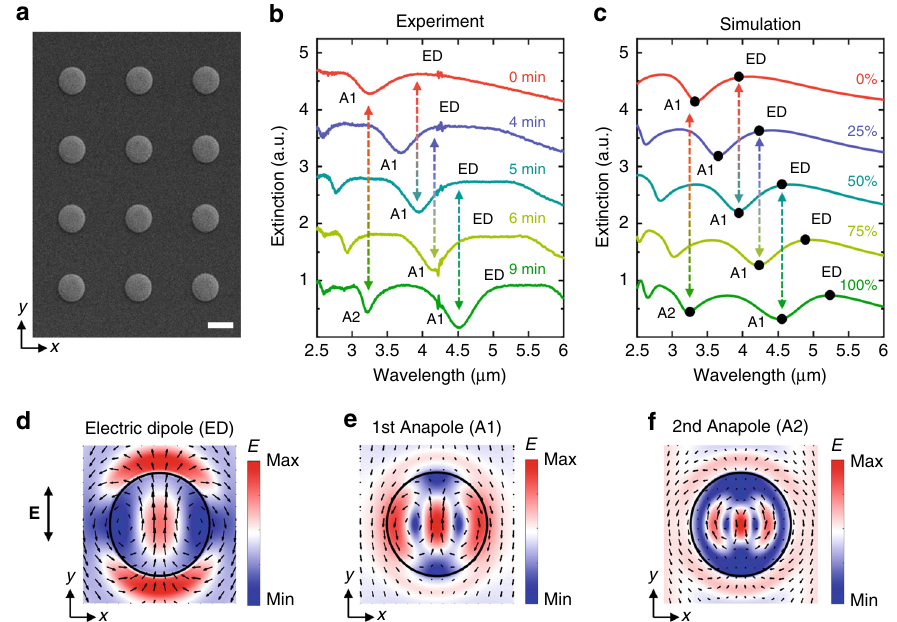
Fig. 3 Experimental realization of active tunable anapole states in structured GST nanodisks. a SEM image of the fabricated GST disks. The scale bar represents 2 μ m. b , c Experimental ( b ) and simulated ( c ) extinction spectra of GST disks with radius R = 1 μ m and height H = 220 nm. A1 and A2 denotes the 1st-order and the 2nd-order anapole states, respectively. d – f Near- fi eld distributions of the ED, A1, and A2 states in the middle planes of the aGST, 50% – cGST and 100% – cGST disks,